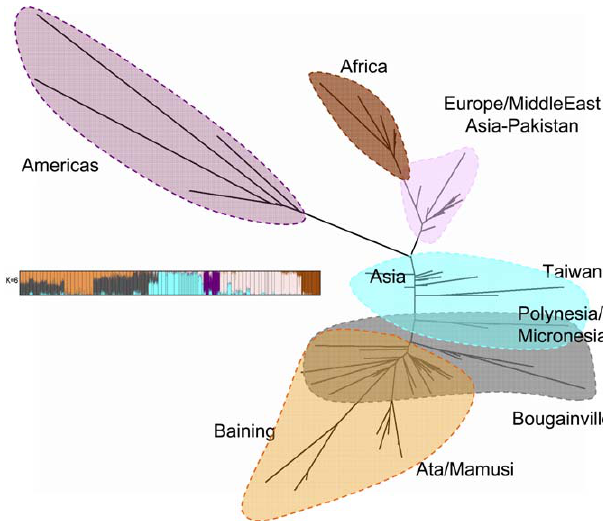
Figure 5. Global Population Tree Neighbor-joining F ST -based tree for the Pacific and HGDP-CEPH combined datasets (687 microsatellites). Superimposed colors are from the STRUCTURE analysis at K ¼ 6 (also shown).